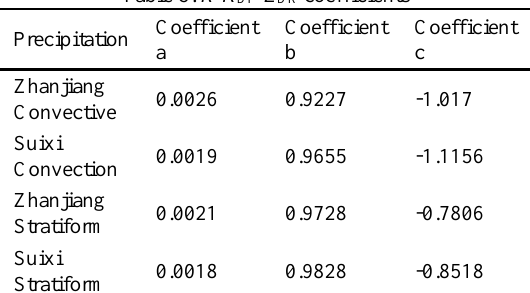
Table 5. R - K DP -Z DR